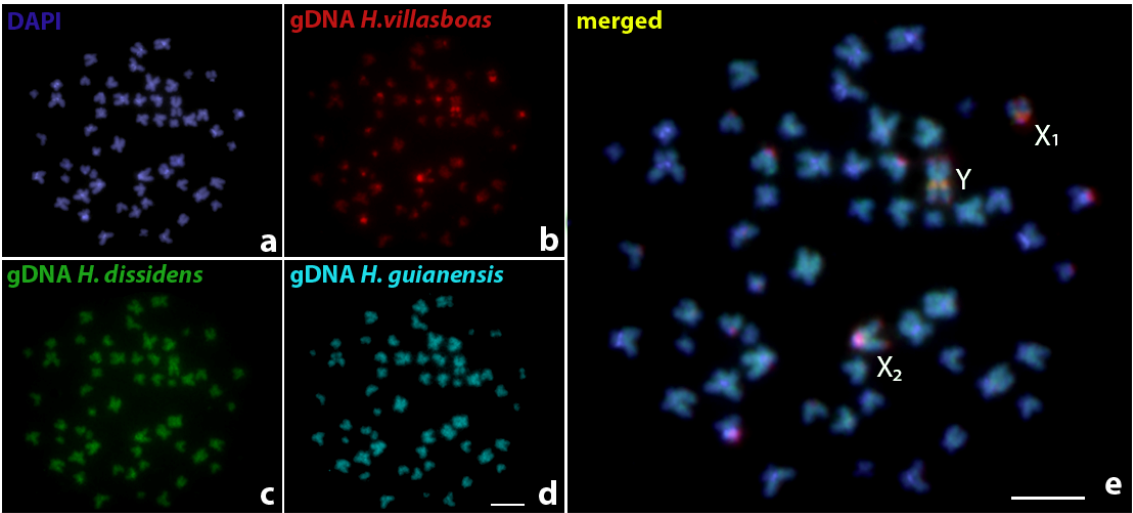
Figure 6. Mitotic metaphase from Harttia villasboas male after interspecific comparative genomic hybridization (CGH). Chromosome spreads were probed with male-derived genomic probes from Harttia villasboas (red) ( b ), H. dissidens (green) ( c ), and H. guianensis (light blue) ( d ). The composed image ( e ) contains all three merged genomic probes and DAPI counterstaining ( a ). The genomic regions with shared excessive hybridization of applied male genomic probes are yellowish. Scale bar = 10 µm.